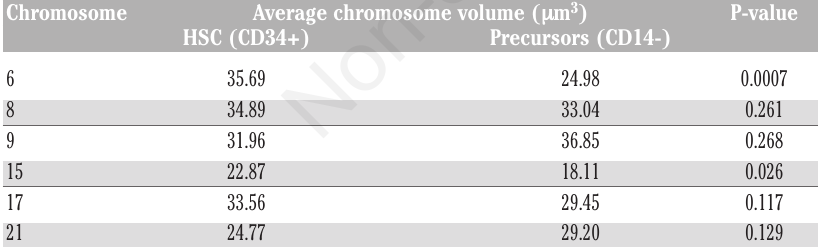
Table 2. Average chromosome volume quantified considering the voxel values. P-values are calculated with a Mann-Whitney rank sum test (U-Test). The number of analyzed nuclei per chromosome per cell type was 30.